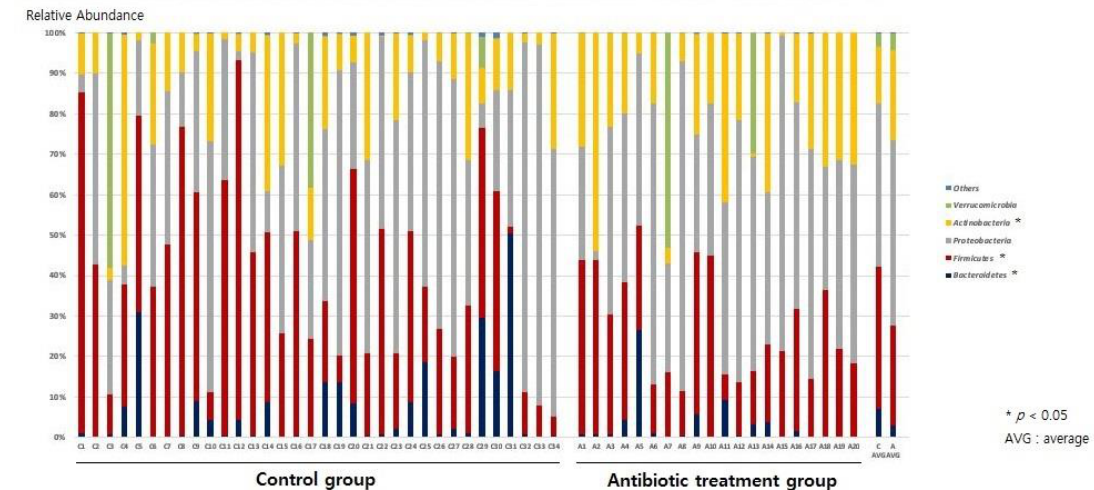
Figure 1. Gut microbiome composition at the phylum level.